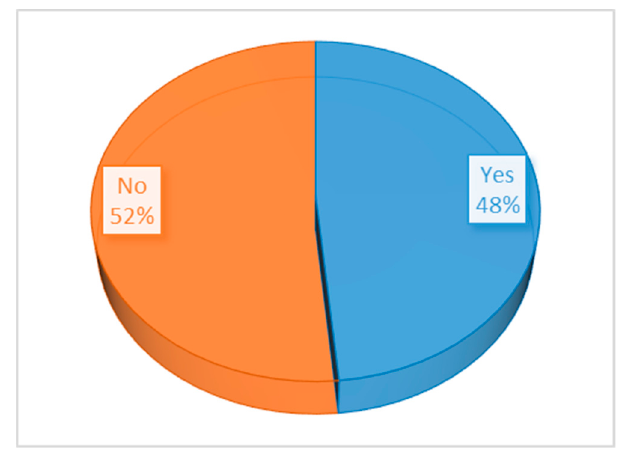
Figure 7. Developing company’s own technologies.